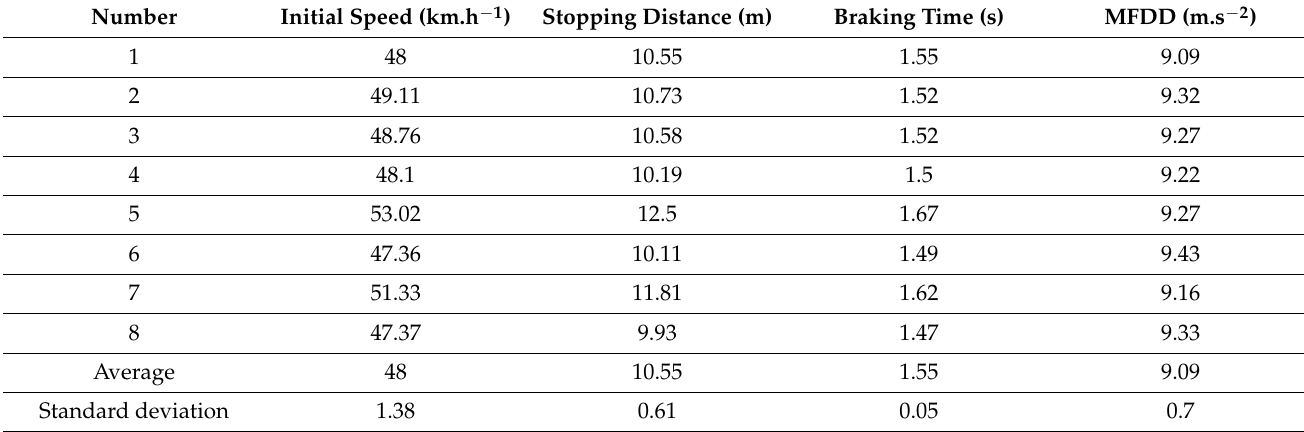
Table 6. Braking characteristics measured with mid-priced brake